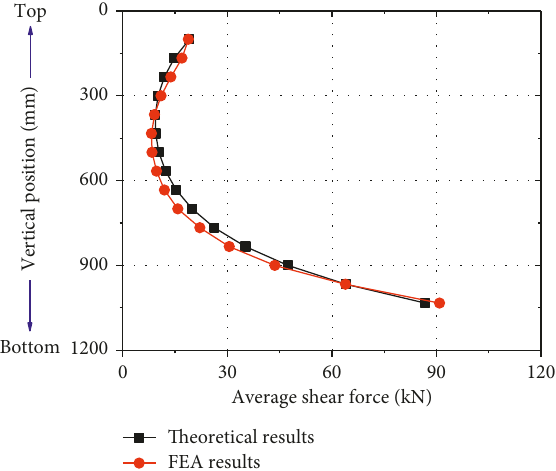
Figure 14: Contrast of shear force distribution.